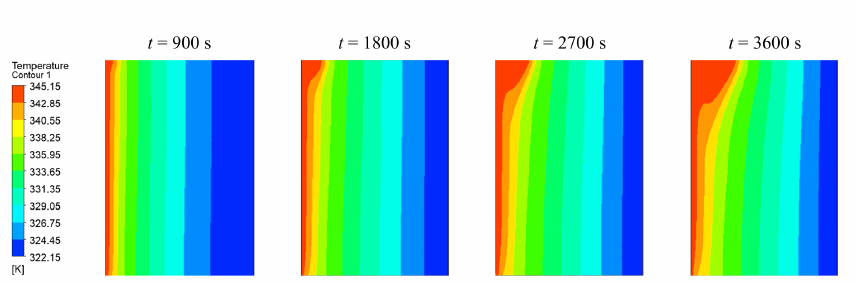
Figure 8. Temperature distribution using AHC model after 900s, 1800s, 2700s, and 3600s.